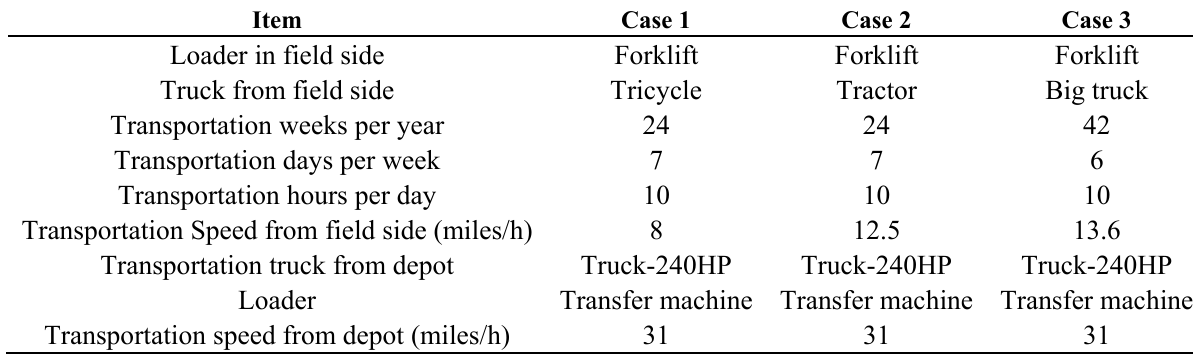
Table B2. Equipment and other elements used during transportation.